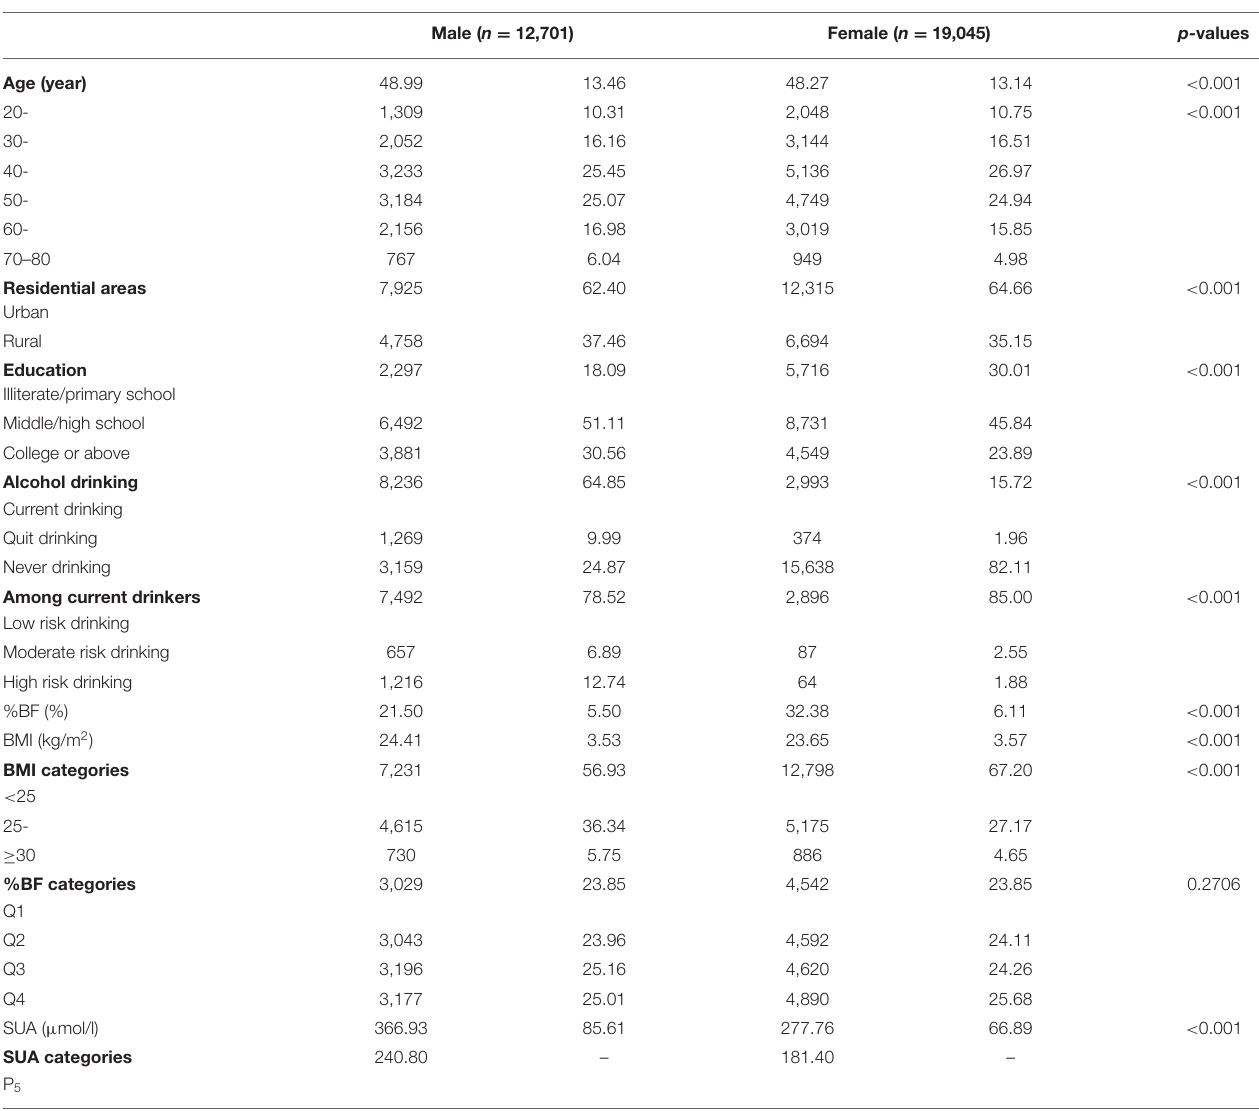
TABLE 2 | Basic characteristics of the study participants in